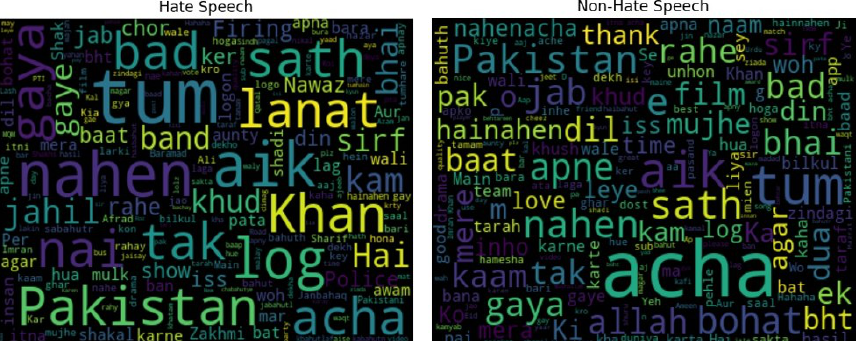
Figure 7. Frequency distribution of the tokens for cyberbullying and non-cyberbullying comments by Roman Urdu users.